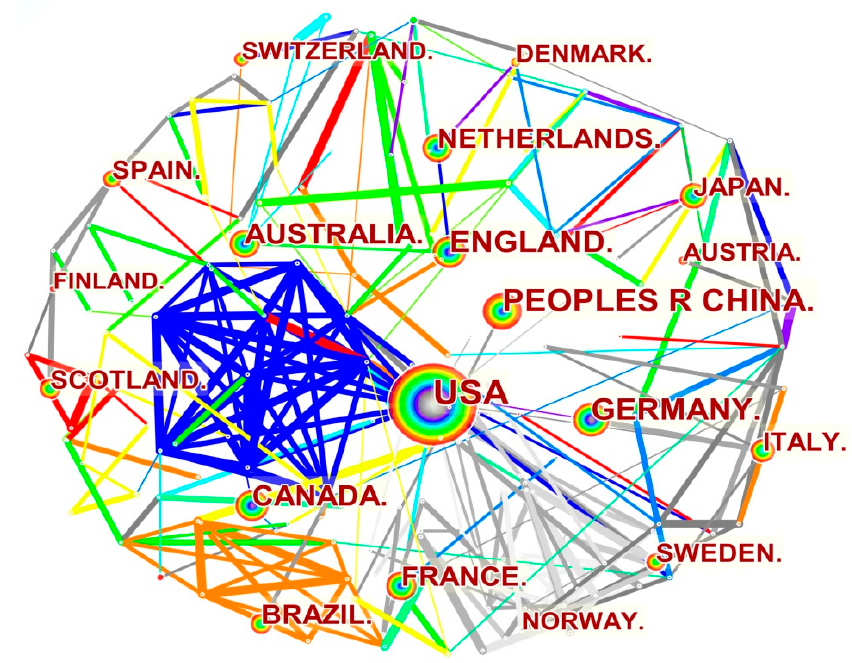
Figure 2. Visualization map of nations for carbon emissions research in the WoS database .